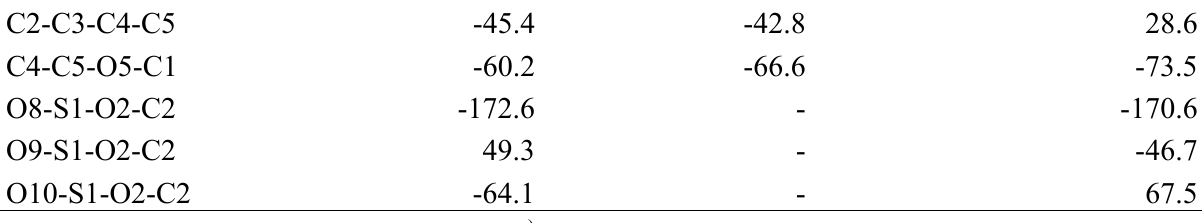
H [Hartree], relative energies [kcal/mol] in 3